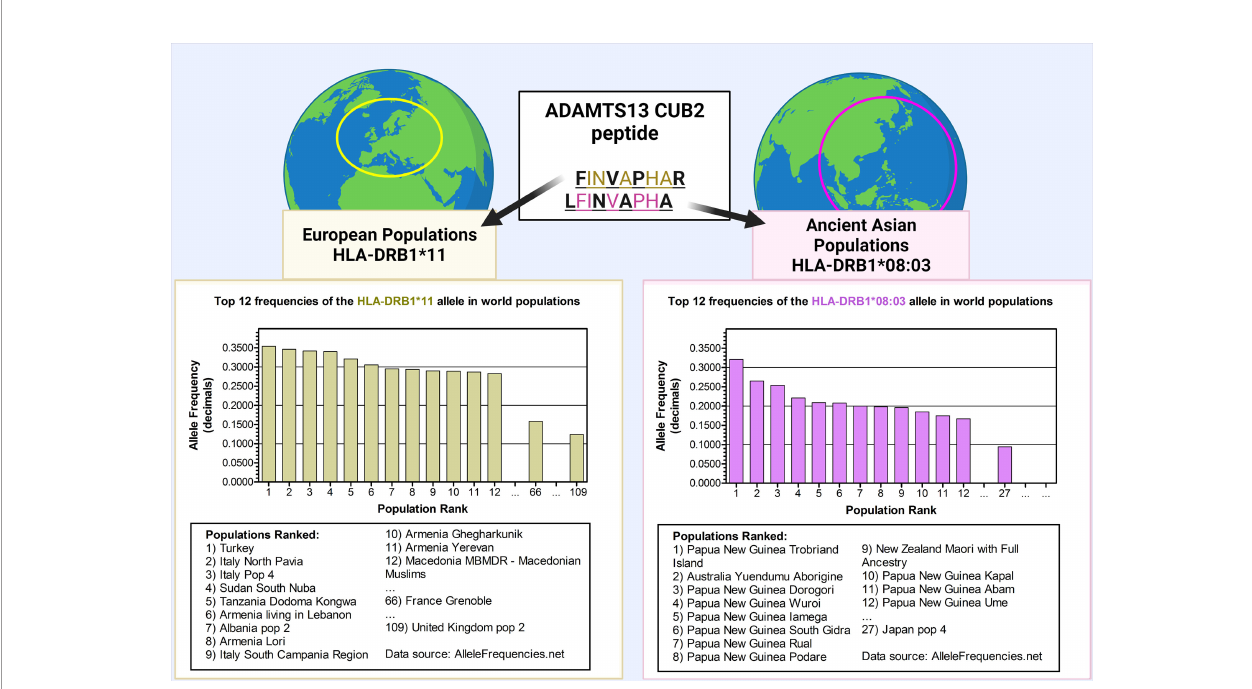
FIGURE 1 | The frequency of the predisposing alleles HLA-DRB1*11 and HLA-DRB1*08:03 in world populations. The HLA-DRB1*11 allele was found to be a predisposing factor in the European Caucasian populations. However, in Asian populations, the predisposing allele was found to be HLA – DRB1*08:03. These alleles bind the same ADAMTS13 peptide derived from the CUB2 domain, however it is predicted that in the context of HLA-DRB1*08:03, the HLA-DRB1*11:01-presented peptide FINVAPHAR is shifted with one amino acid, becoming LFINVAPHA. The top 12 world populations are shown with the highest frequencies for each allele. The fi rst countries in the list are the countries in their continent (France and UK for Europe, and Japan for Asia) where the main association studies were performed. HLA- DRB1*11 allele was found to be not frequent in far-east Asian populations. The fi rst far-east Asian population in the list is the Taiwan Hakka pop 2 (rank number 184, with frequency of 0.0960; – other middle-eastern populations in Armenia, Georgia, Iran, Iraq, and central Russia, as well as central-Asian populations in Pakistan and India, rank higher). Conversely, HLA-DRB1*08:03 was found to be not frequent in European populations, with the highest-ranking European population on the list being Portugal center (ranked as 106, with frequency 0.0200). Data source: allelefrequencies.net (access date: 20 th July 2021). Figure created with